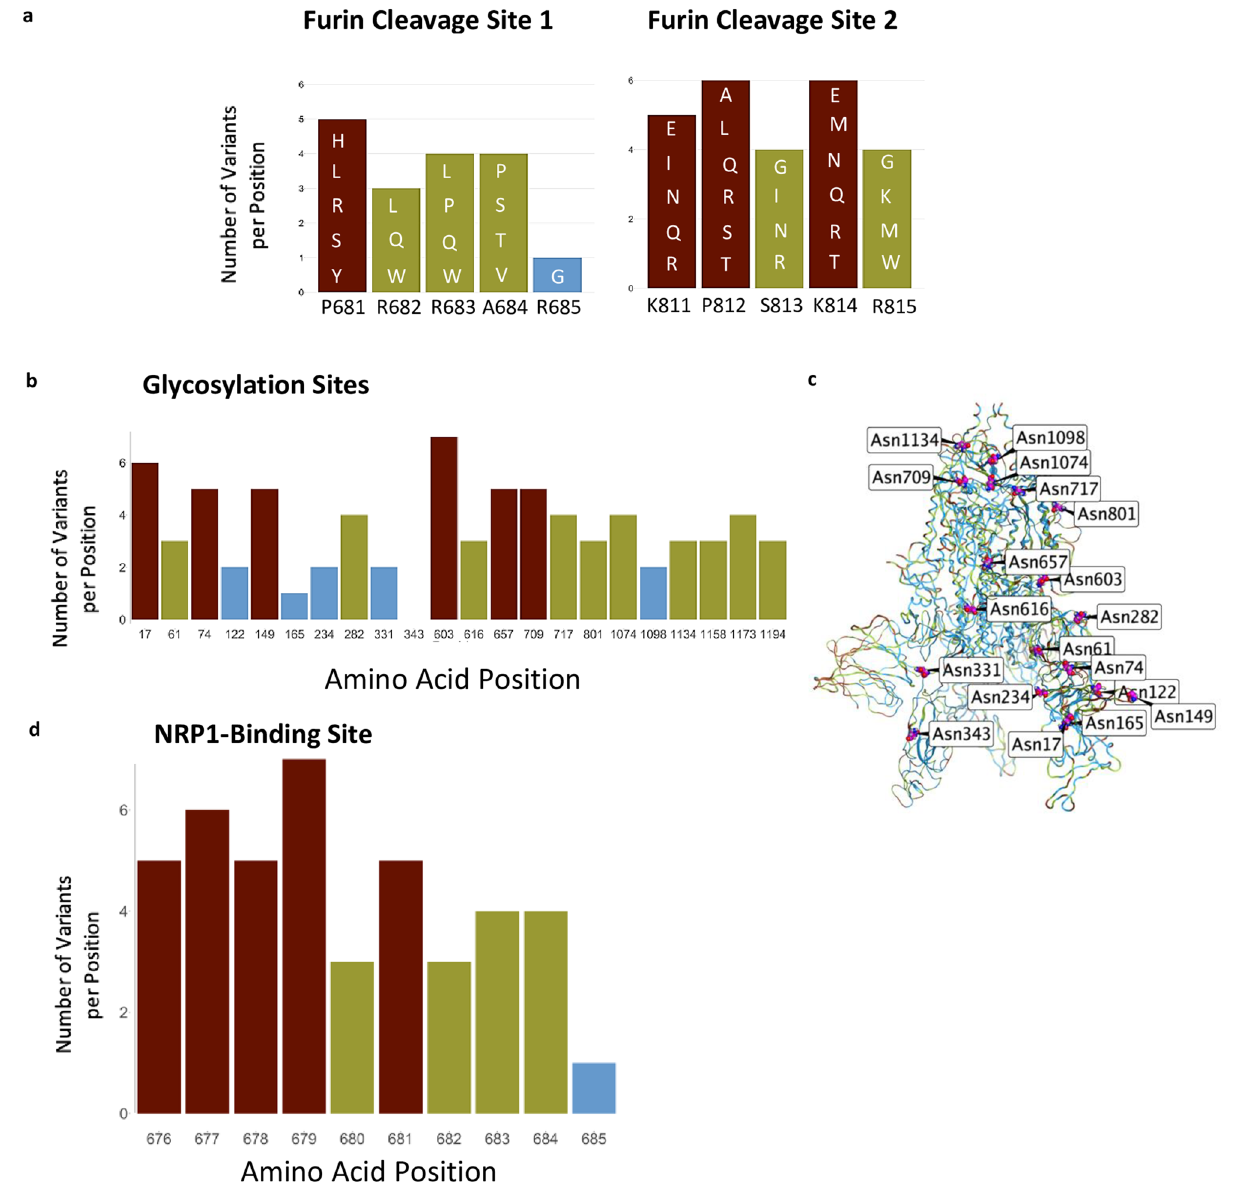
Figure 2. Furin cleavage sites, glycosylation sites, and NRP1 interaction site. ( a ) Furin cleavage sites in the S protein. Amino acid indicated below each bar indicate the sequence in the WIV04 index isolate. Variants in other SARS-CoV-2 isolates are indicated within the bars of the graphs using one letter abbreviations for the amino acids. ( b ) The 22 glycosylation sites in the S protein; indicated are the number of variants per position. ( c ) Glycosylation asparagine sites (numbered) are highlighted in pink in the S protein. ( d ) The number of variants in the proposed NRP1-binding